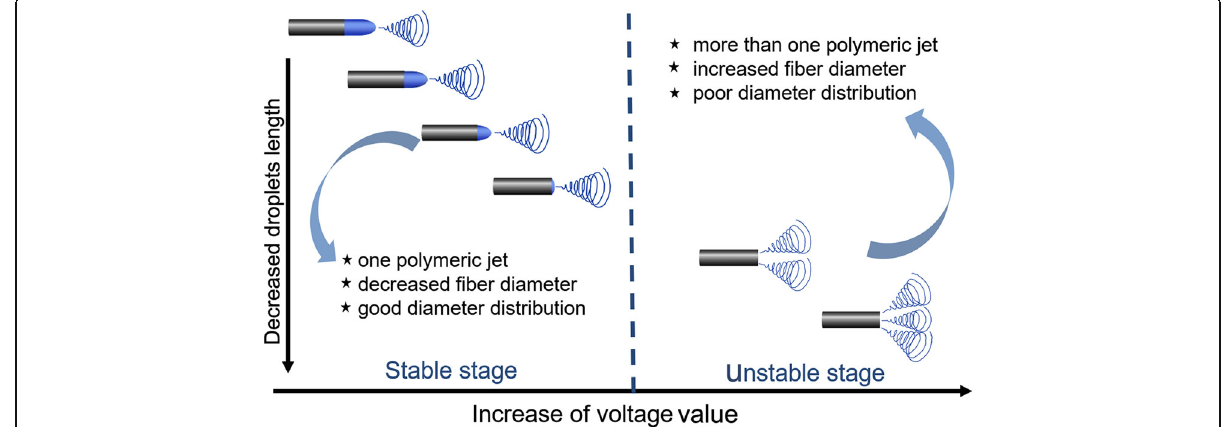
Fig. 10 The schematic diagram of spinning process and jet evolution with the increase of voltage value